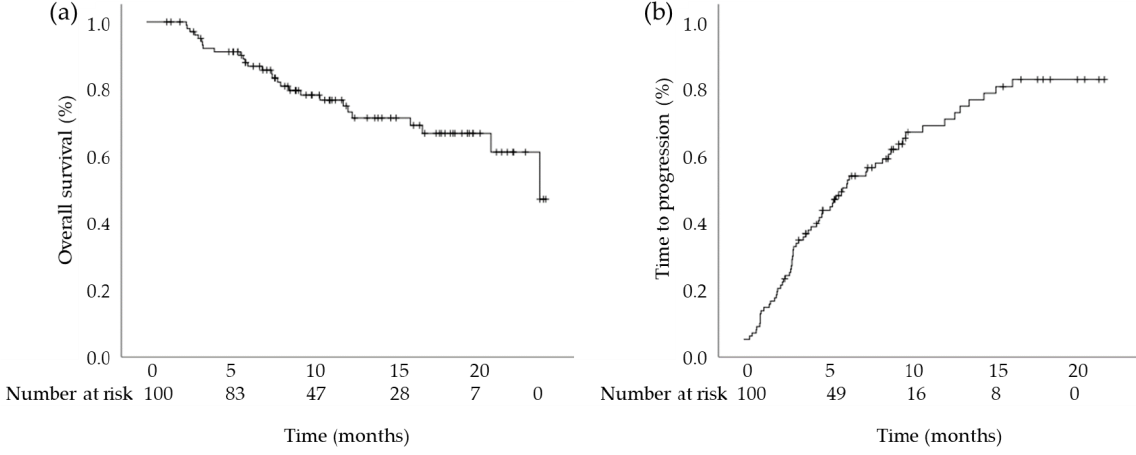
Figure 2. Kaplan–Meier estimates of cumulative ( a ) overall survival and ( b ) time to progression.